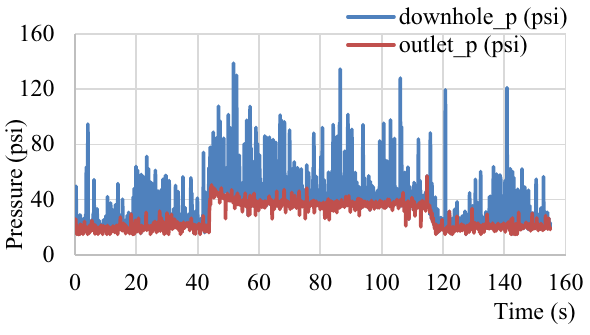
Fig. 11 Effects of gas kick on ROP for experimental Run_2